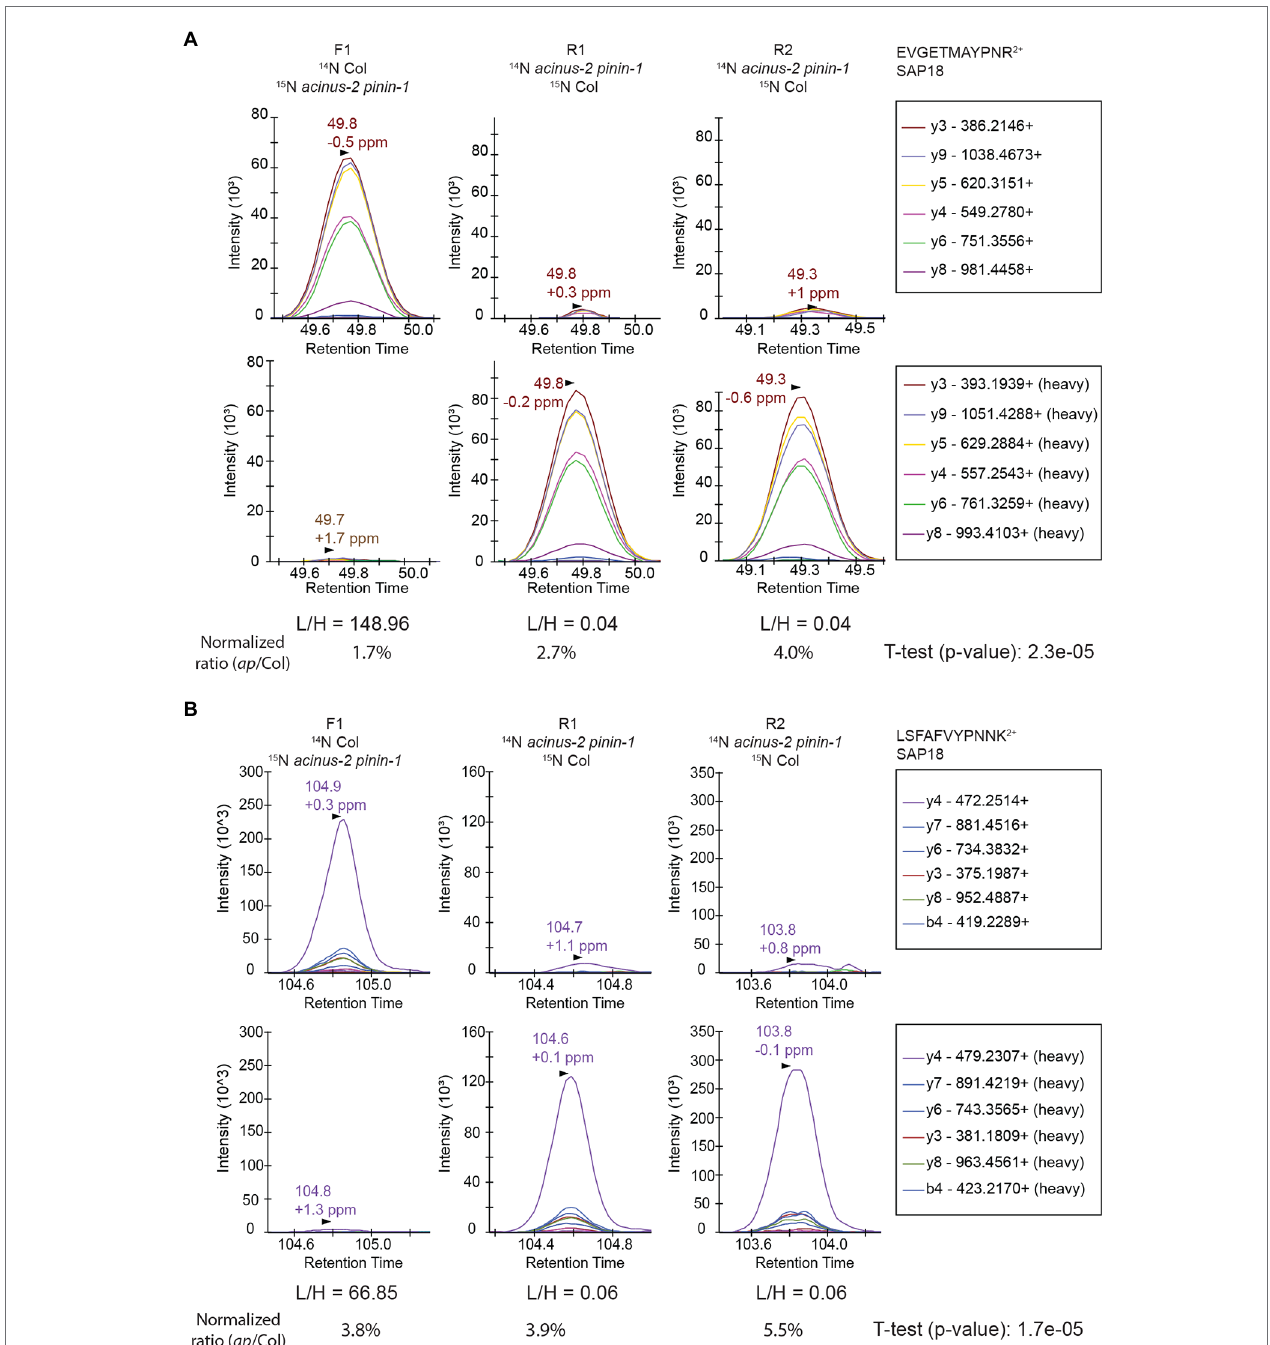
FIGURE 6 | Targeted quantification using PRM on SAP18 proteins provides unambiguous quantification results. The targeted quantifications in three samples gave consistent results showing SAP18 was dramatically reduced in acinus-2 pinin-1 mutant after normalization to TUB2. The light and heavy peptides gave a similar pattern of fragmentation. The peptides are quantified using area under the curve (AUC). (A) PRM results from peptide “EVGETMAYPNR” confirm the heavy matching peaks in Figure 4C is indeed from a co-eluting 14 N labeled peptide; (B) PRM results from peptide “LSFAFVYPNNK” confirm the matching 14 N peak in MS 1 Figure 4E from DDA data is indeed contaminated with overlapping